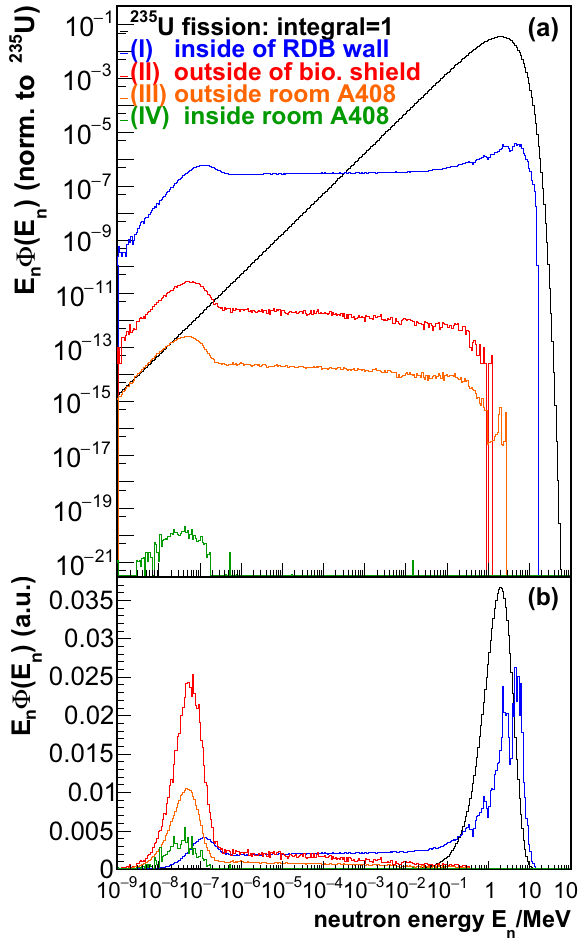
Fig. 19 a MC neutron spectra of the propagation from the reactor core to room A408, the fission spectrum is normalized to 1 b same spectra as in a with a linear y-axis scaled arbitrarily to make spectral features